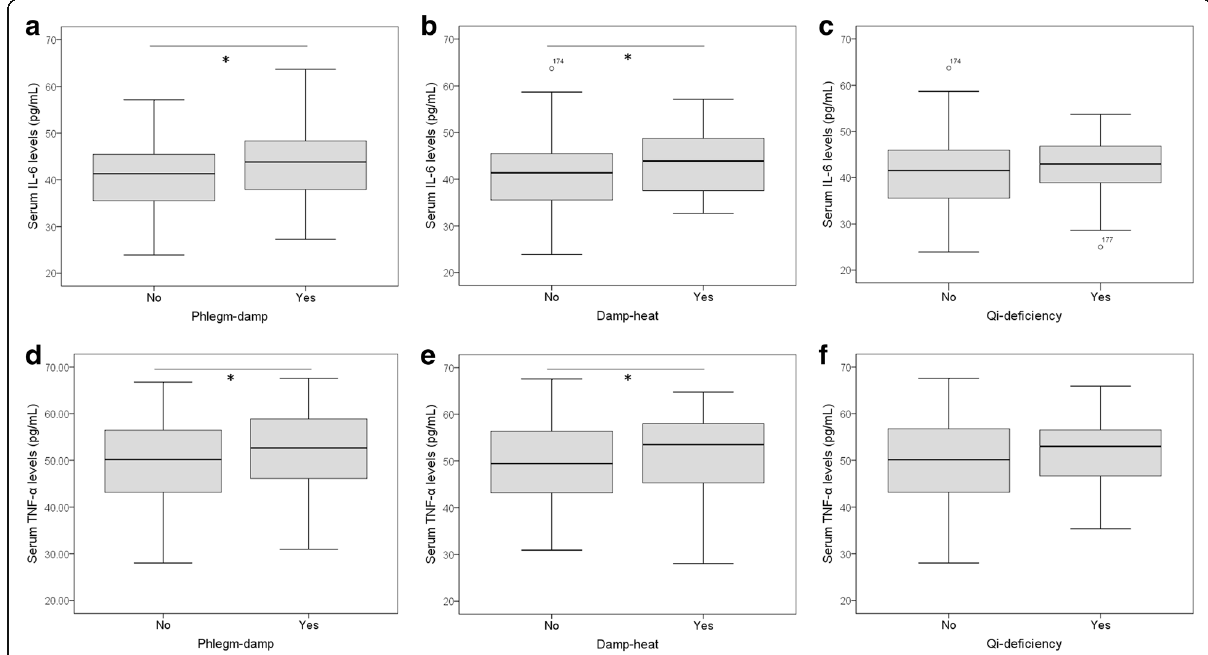
Fig. 2 Serum levels of inflammatory mediators in IGR subjects with TCM body constitutions. Serum levels of IL-6 and TNF- α were measured by ELISA, and their associations with Phlegm-damp ( a, d ), Damp-heat ( b, e ) and Qi-deficiency ( c, f ) were investigated. Serum IL-6 and TNF- α levels are significantly higher in IGR subjects with Phlegm-damp or with Damp-heat constitutions as compared with IGR subjects without respective constitutions. Box plots are displayed, where the bold black line indicates the median per group, the box represents 50% of the values, and horizontal lines show minimum and maximum values of the calculated non-outlier values; open circles indicate outlier values. Wilcoxon-Mann-Whitney test was performed. *P<0.05. IGR: impaired glucose regulation; IL-6: interleukin 6; TNF- α : tumour necrosis factor-